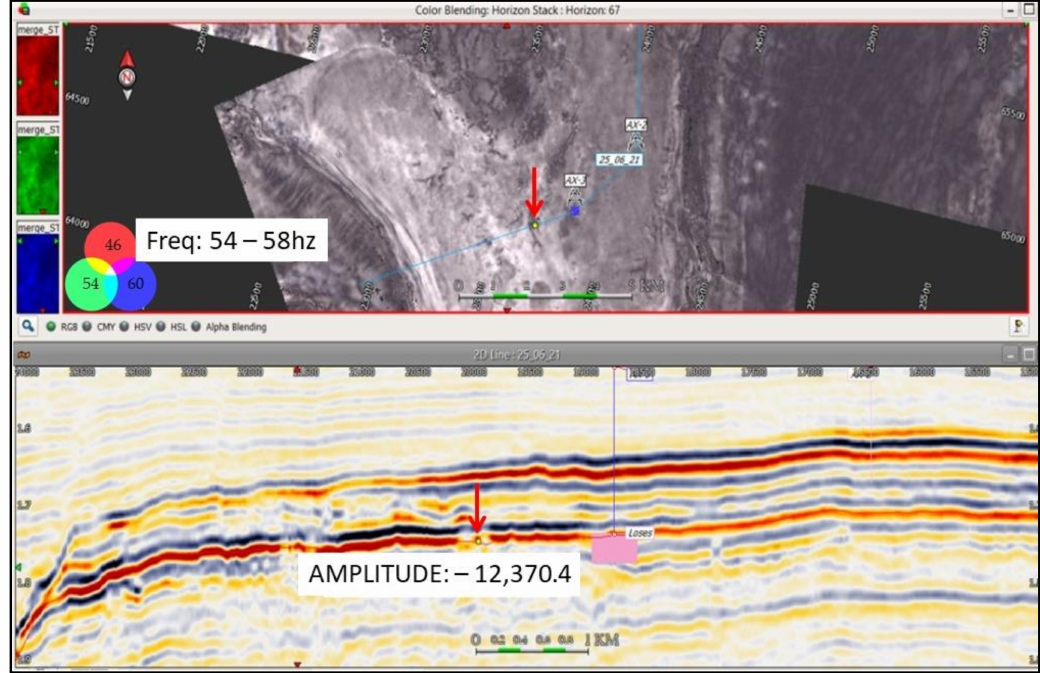
Figure 6. Targeted dendritic pattern and high amplitude karst features shown in the red arrow for frequency